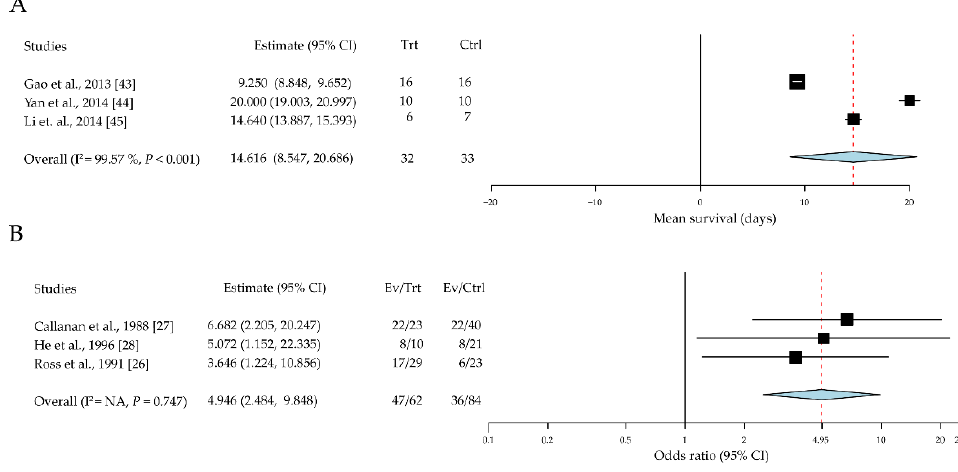
Figure 2. The role of the dendritic cells in allograft survival. ( A ) Immature dendritic cells promote allograft survival; ( B ) Langerhans cells increase the allograft rejection rate. CI, confidence intervals; EV, event; Trt, treatment; Ctrl, control.